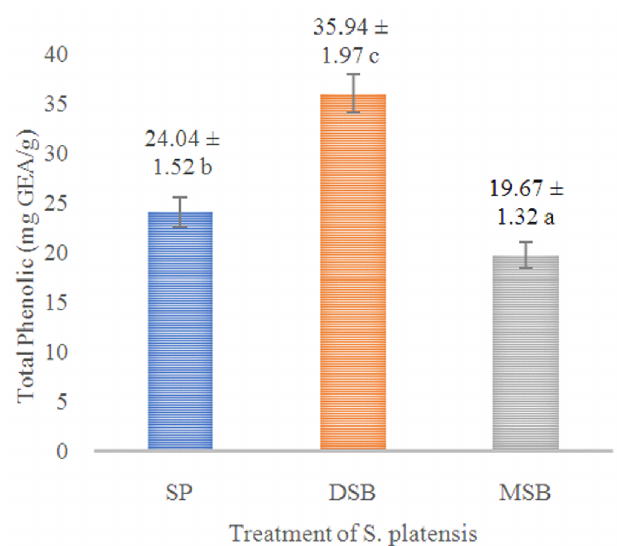
Figure 1. Total phenol content (n=3, mean value ± standard deviation; different superscripts indicate a significant difference). SP = S. platensis with no treatment, DSB = S. platensis treated with freeze-dried O. basilicum , MSB = S. platensis treated with microencapsulation freeze-dried O. basilicum .